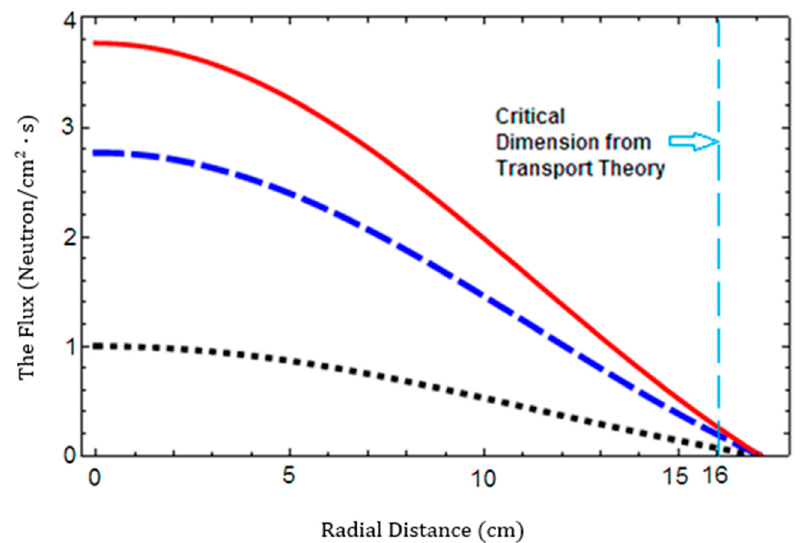
Figure 1. Two energy groups fluxes for a sphere made of 93% enriched U. Dotted line: Thermal flux, Dashed line: Fast flux, Solid line: Total fluxes.